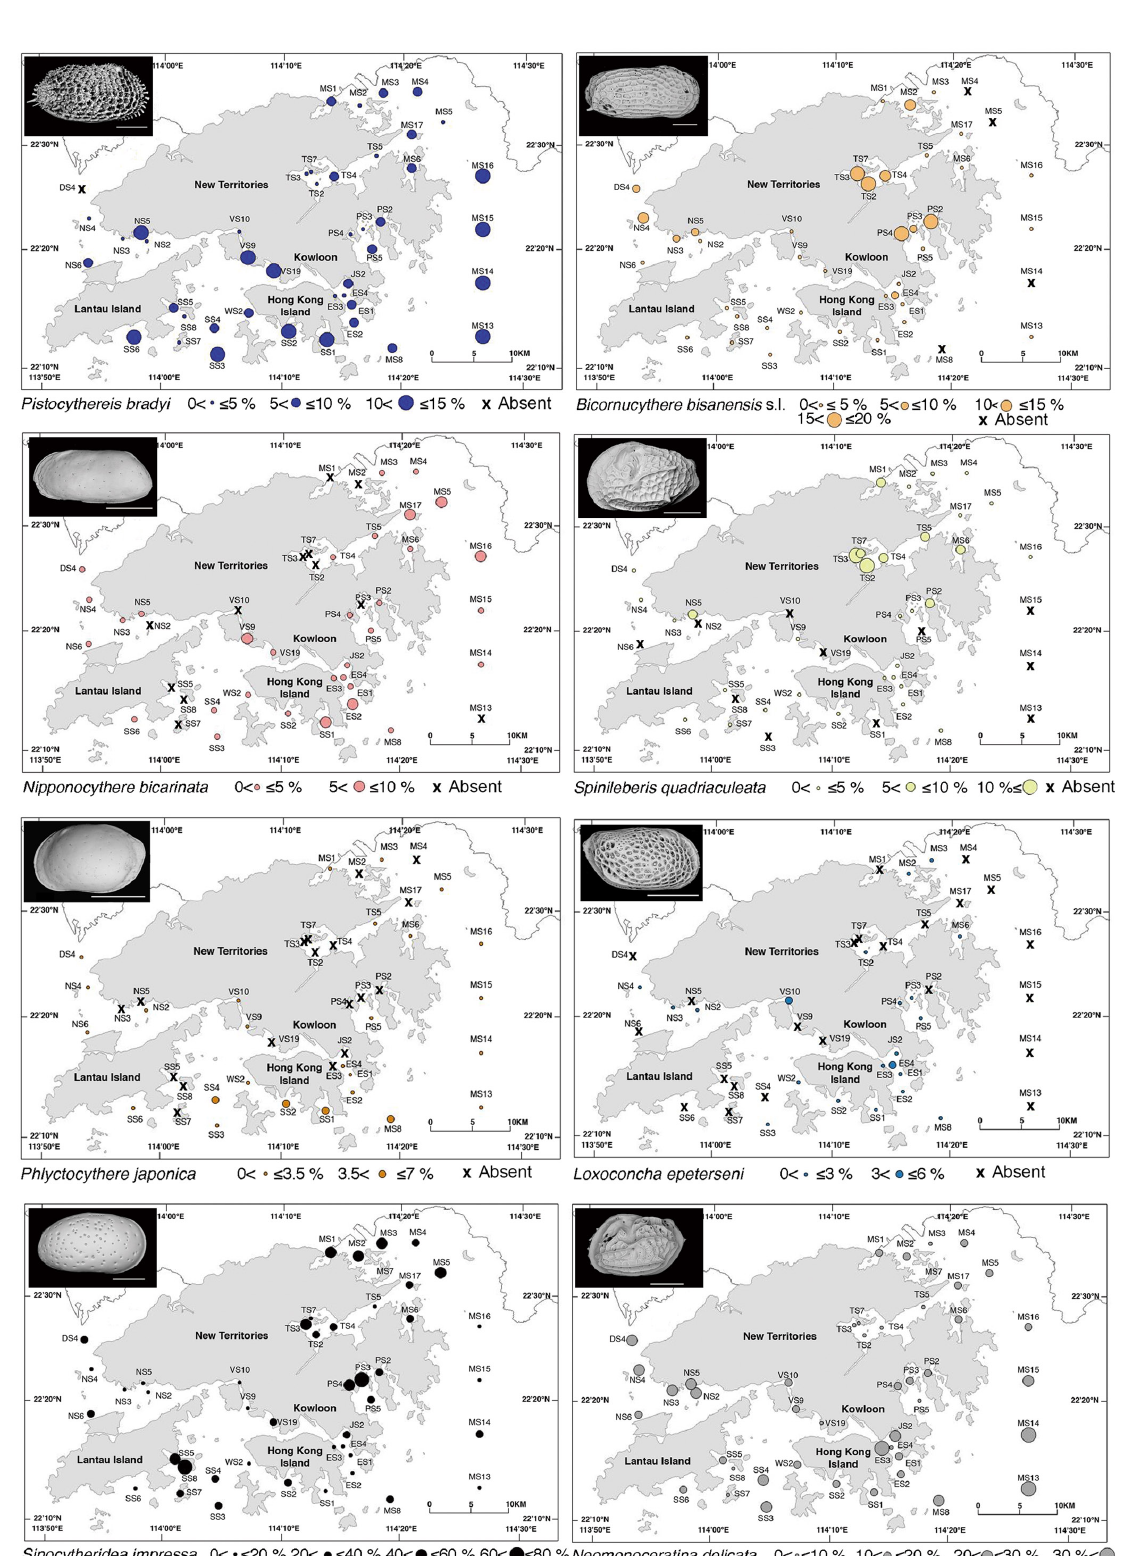
Figure 5. Spatial distribution of the relative abundance for Pistocythereis bradyi , Bicornucythere bisanensis s.l., Nipponocythere bicarinata , Spinileberis quadriaculeata , Phlyctocythere japonica , Loxoconcha epeterseni , Sinocytheridea impressa , and Neomonoceratina delicata in Hong Kong. The scale bar is